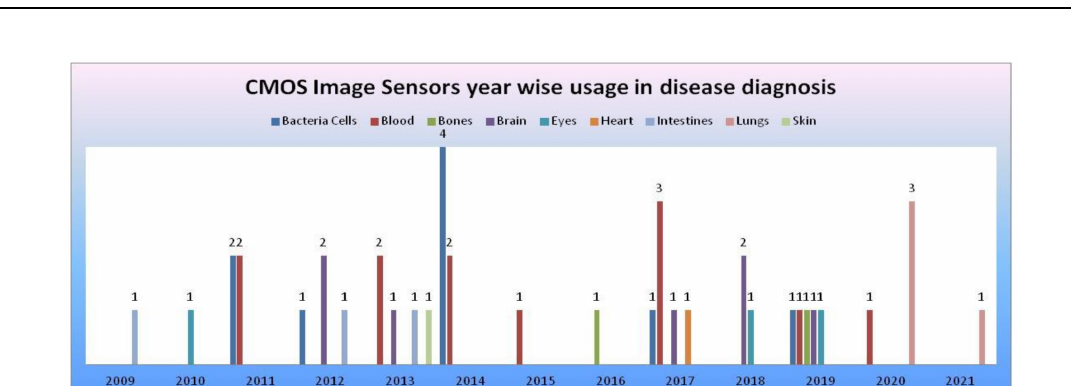
Figure 48. CMOS image sensors year-wise usage in disease diagnosis according to survey data, where the x -axis represents years and the y -axis represents the number of CMOS image sensors involved in disease diagnosis of human body